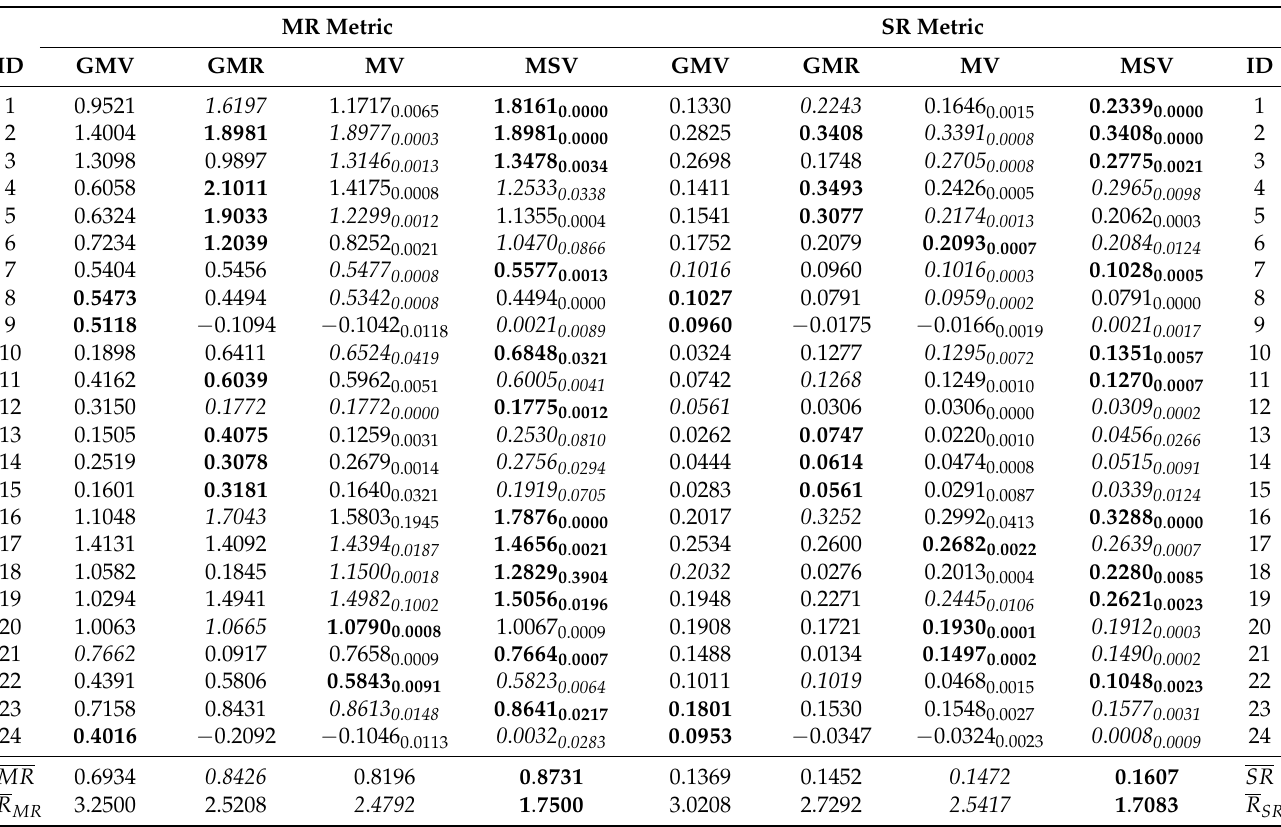
Table 2. Statistical results of the strategies implemented: the mean returns (MR) and Sharpe ratio (SR) out-of-sample performance of each strategy and dataset (MR and SR), mean MR ( MR ), mean MR ranking ( R MR ), mean SR ( SR ) and mean SR ranking ( R SR ). The datasets are denoted by their IDs. The best results are in bold face and second-best results in